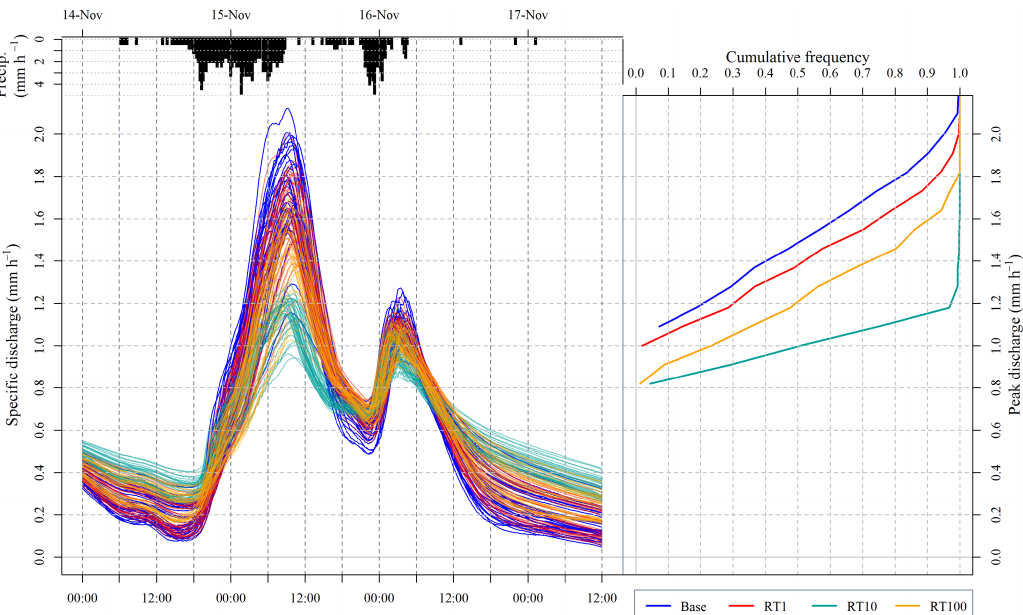
Figure 7. Left: 90th percentile likelihood scored baseline and corresponding intervention cases through Storm Abigail. Right: Likelihood- weighted CDF of peak discharges for base and intervention cases. Note that, in order to share the same vertical axis, the plot axes are is transposed relative to convention.